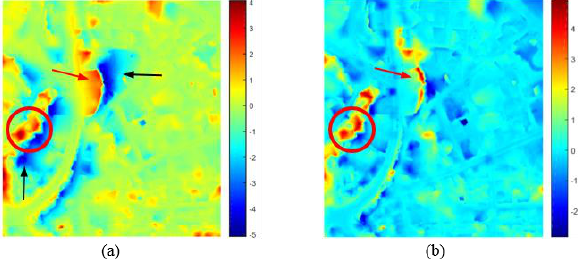
Figure 8. Area (1) height difference maps of the LiDAR DTM compared to the MSD (a) and the NGPs (b). The negative height differences are highlighted by black arrows in Figure 8 and are only presented in the DTM created by the MSD approach. Those differences are up to 4m and compared with the 2m by the NGPs approach will have to be flagged as gross errors. The major reason is that raised ground regions are lost from the ground mask as discussed in Figure 5c. Hence, the created DTM is interpolated under the ground instead of on the ground and therefore are highlighted as incorrect classified. Based on the difference DTMs and after excluding the gross errors, the mean-square error (MSE) and the standard division (SD) are computed and presented in Table 3.